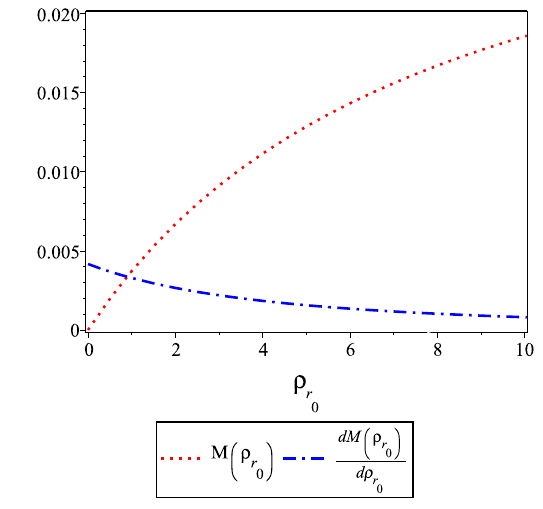
Fig. 9 Static stability of (20) against ρ r 0 . 0001 , R = 0 .